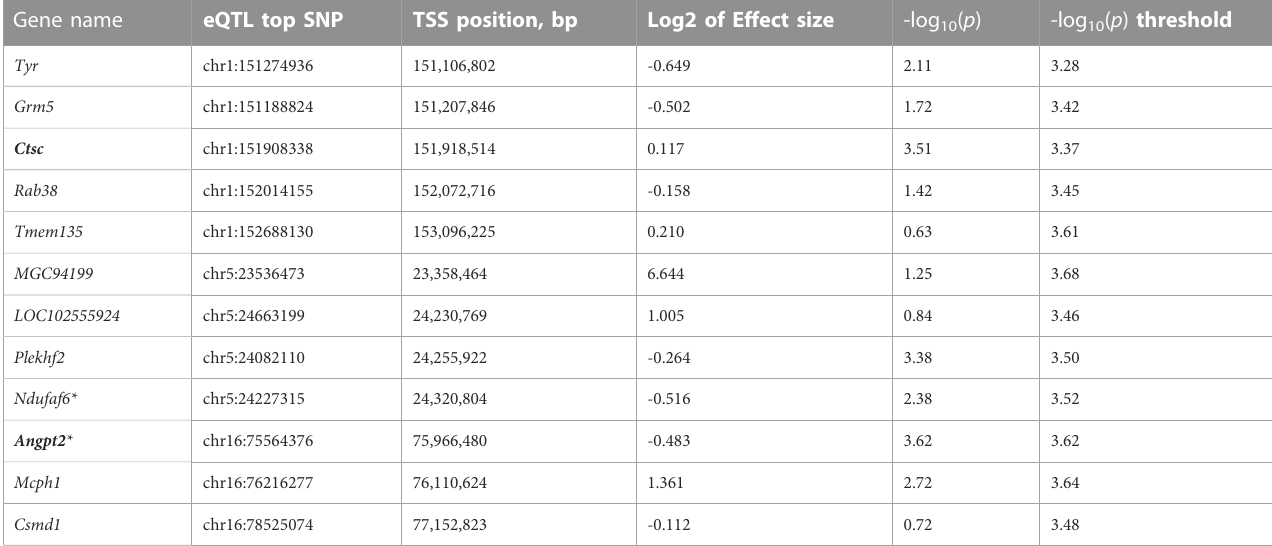
TABLE 3 Association of gene expression with genotypes in QTLs located on chromosomes 1, 5, and 16. These genes are located within the LD region that is de fi ned as r 2 > 0.6 with the top SNP for each QTL. Genes that have cis-eQTL are bolded. *denotes genes that lie just outside the interval of interest, but are included because of supporting evidence from prior